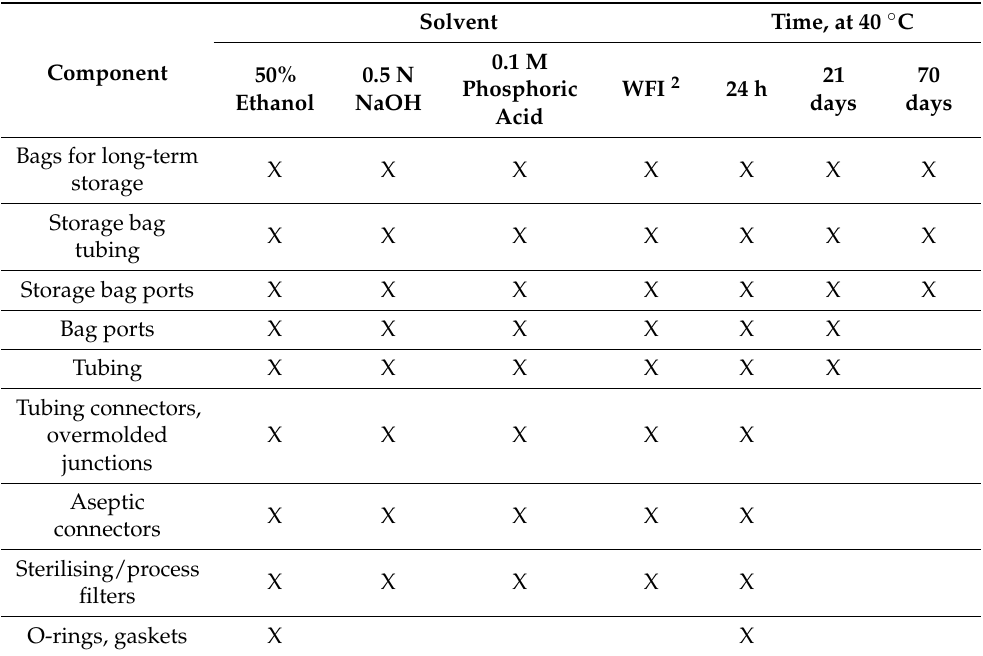
Table 5. Selected conditions for testing of extractables from SUS 1